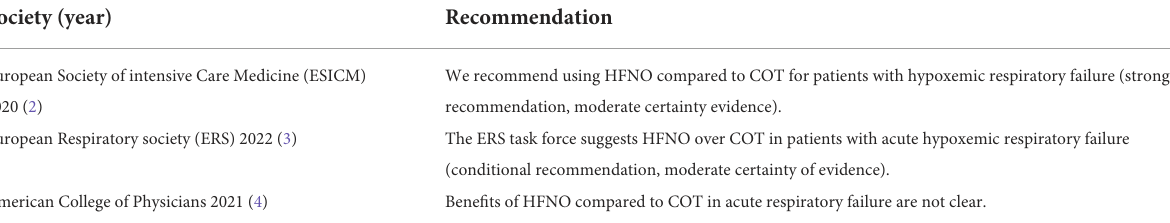
TABLE 2 International recommendations regarding HFNO in acute hypoxemic respiratory